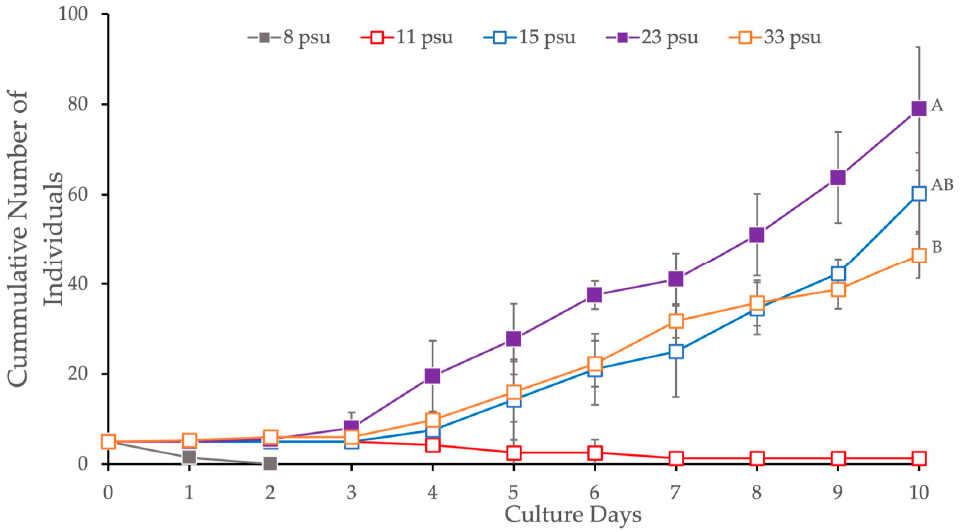
Figure 8. Population growth of A. minuta at different salinities over a 10-day culture period. Data are expressed as means ± SD; each of the salinity treatments started with five anemones at day 0 (n = 4–7). Letters beside the 10th day of the dotted line graph denote significant differences in relation to the other salinity treatments ( p < 0.05, n = 4, A > B).